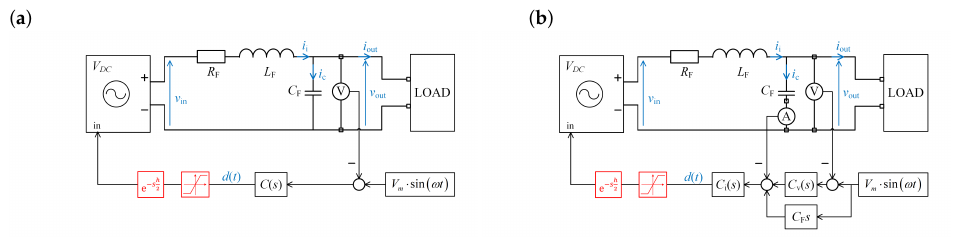
Figure 11. Schematic diagrams of QCT models for hybrid control systems depicted in Figure 2: ( a ) 1Lh-single loop and ( b ) 2Lh-double-loop with the capacitor current